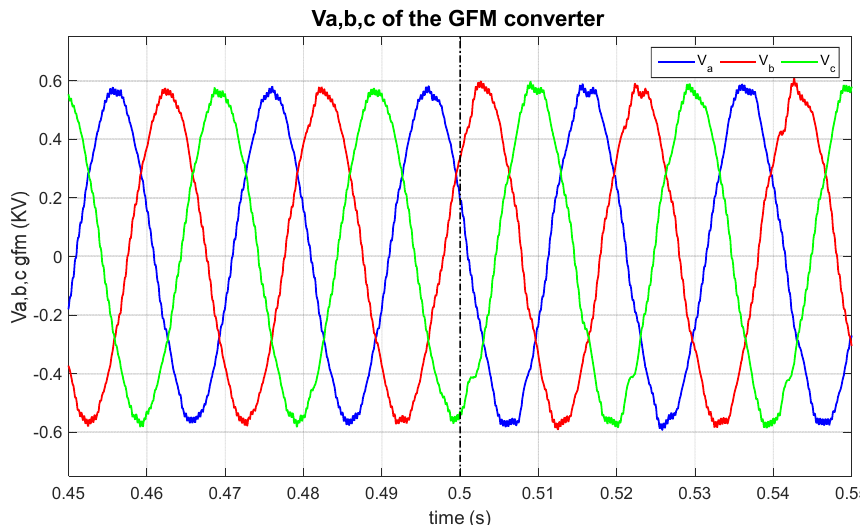
Figure 20. Instantaneous phase voltages during the transition to islanded mode.